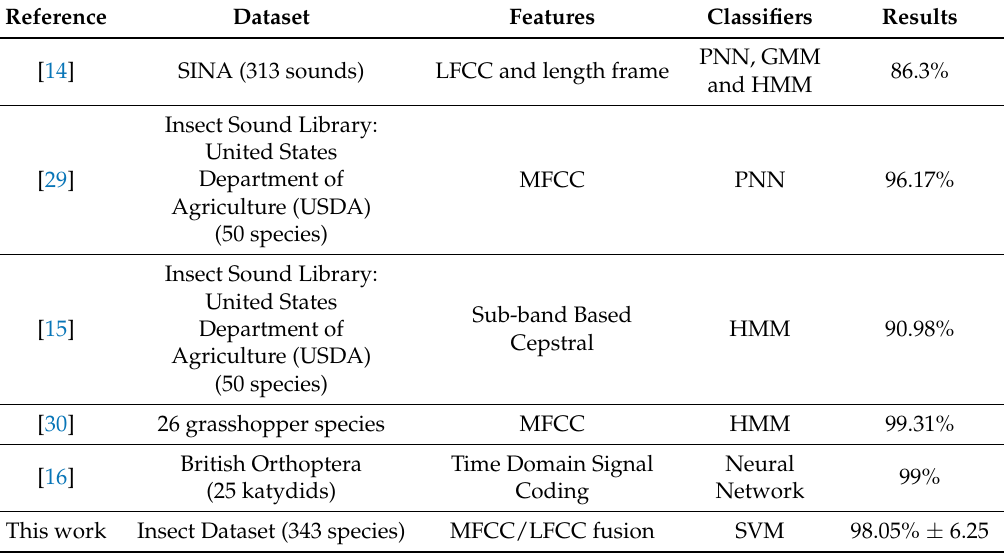
Table 2. Comparison of the proposal vs. the